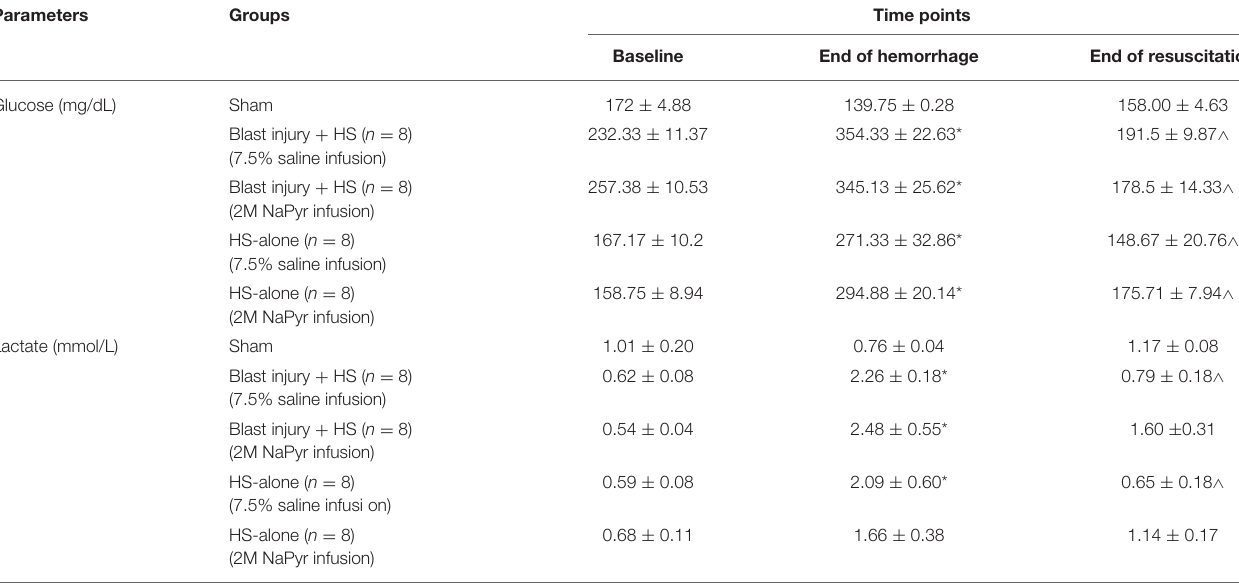
TABLE 3 | Blood metabolites in mean ± SE.